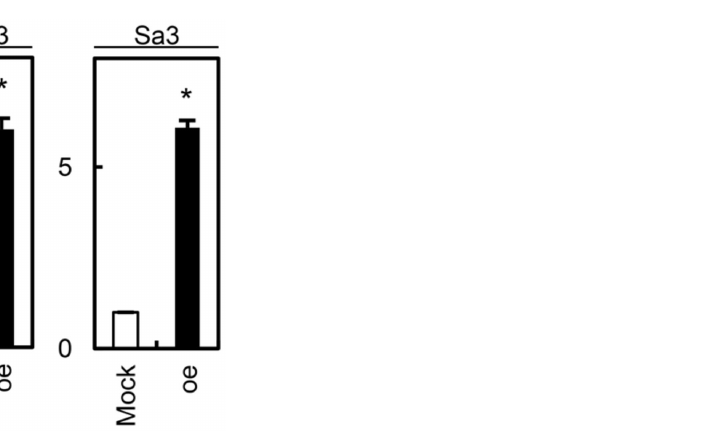
Figure 5. Establishment of circRNA-102450 overexpression in OSCC cells (HSC-3 and Sa3). Overex- pression of circRNA-102450 was observed in HSC-3 and Sa3 cells after transfection with a circRNA- 102450 overexpression vector. Data are expressed as means ± SD (* p < 0.05). oe, oe-circRNA- 102450 cells.